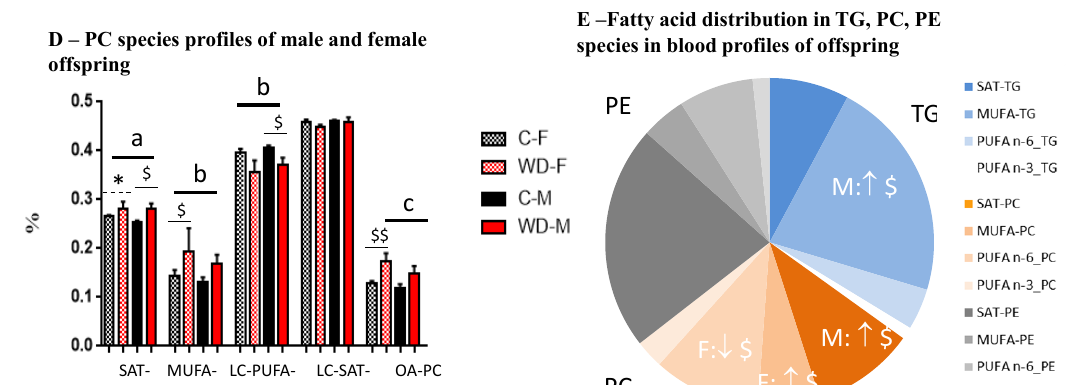
Figure 6. ( A ) PCA analysis reveals an influence of maternal diet during gestation and lactation on male and female o ff spring blood lipidome at day 25 of lactation period. PCA score plot on the two first dimensions of the PCA, accounting for 59% of the total variance for 62 data points (TGs), reveals natural clusters for all the male (MC, MWD) and female (FC, FWD) o ff spring and according to maternal diet (C, WD). The PCA model presented a cumulative modeled variation (R2X) value of 95% and 92% and a cumulative predicted variation (Q2Y) value of 83% and 14% for maternal diet and o ff spring sex groups, respectively, for 22 data points (Cer-SM), indicating good agreement. Score plots from PLS-DA classification of o ff spring blood TGs ( B ) and sphingolipids ( C ) species according to maternal diet (C, WD). Only one sample (FWD1) was identified as outlier according to the Hotelling’s T2 grey circle, corresponding to a multivariate generalization of the 95% confidence interval. ( D , E ) Fatty acids distribution in phosphatidylcholines (PC species), phosphoethanolamines (PE species) and triglycerides (TG species) in blood of male and female o ff spring of both WD and C groups (data of sphingolipids were detailed in Table 3). Values were mean ± SEM ( D ) or mean ( E ). For each biomarker, values of p -values (assessed by Mann–Whitney U test) between “western diet” and “control diet” groups, regardless of sex group , were reported with a, b, c significantly di ff erent; p < 0.05, p < 0.01 or p < 0.001, respectively. Values of p -values (assessed by Mann–Whitney U test) between “female” and “male” groups considering each diet group , were reported with *, p < 0.05 significantly di ff erent. Values of p -values (assessed by Mann–Whitney U test) between “western diet” and “control diet” groups considering each sex group were reported with $, p < 0.05 and $$ p < 0.01 significantly di ff erent. SAT: saturated fatty acids (C8:0 to C14:0); MUFA: Monounsaturated fatty acid; LC-SAT: Long-chain saturated fatty acids (that contains at least 16 carbons); LC-PUFA: Long-chain PUFA (polyunsaturated fatty acid that contains at least 16